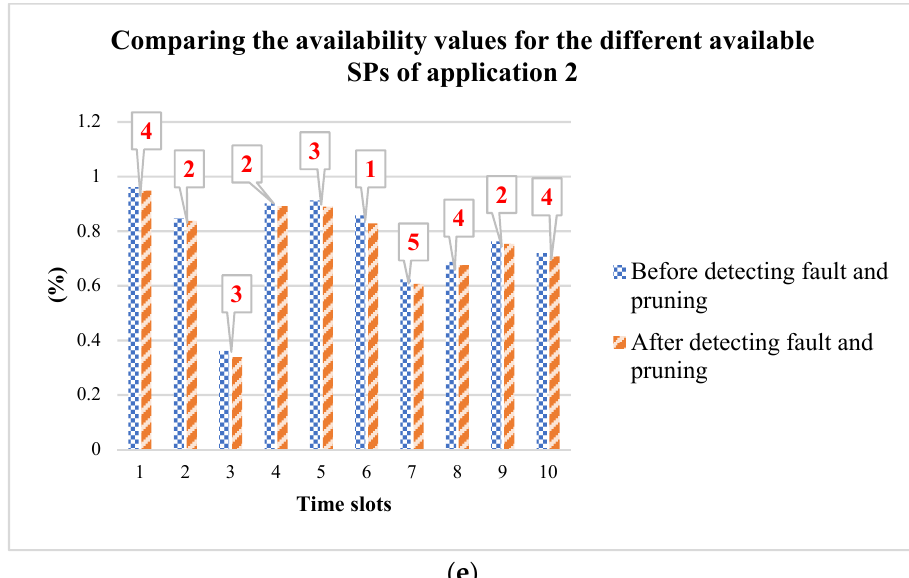
Figure 12. Comparing availability, the delay and energy before and after detecting the faults in application 2: ( a ) Comparing the total delay between three phases of before pruning, after detecting fault and pruning, and after detecting fault without pruning; ( b ) Comparing the total energy between three phases of before pruning, after detecting fault and pruning, and after detecting fault without pruning; ( c ) Comparing total energy between QAC and other related works (Without CAS); ( d ) Comparing total delay between QAC and other related works (Without CAS); ( e ) Comparing availability before and after detecting the fault and pruning for the different available SPs of application 2 (Red colored indexes demonstrate the SP numbers).